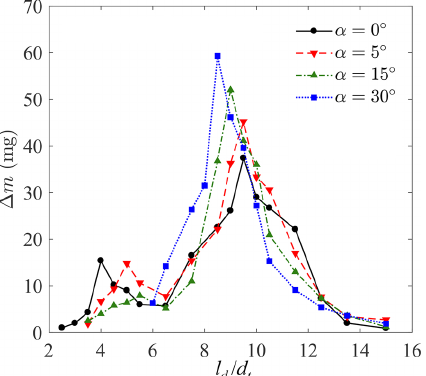
Figure 3. Mass loss at various oblique angles across serial standoff